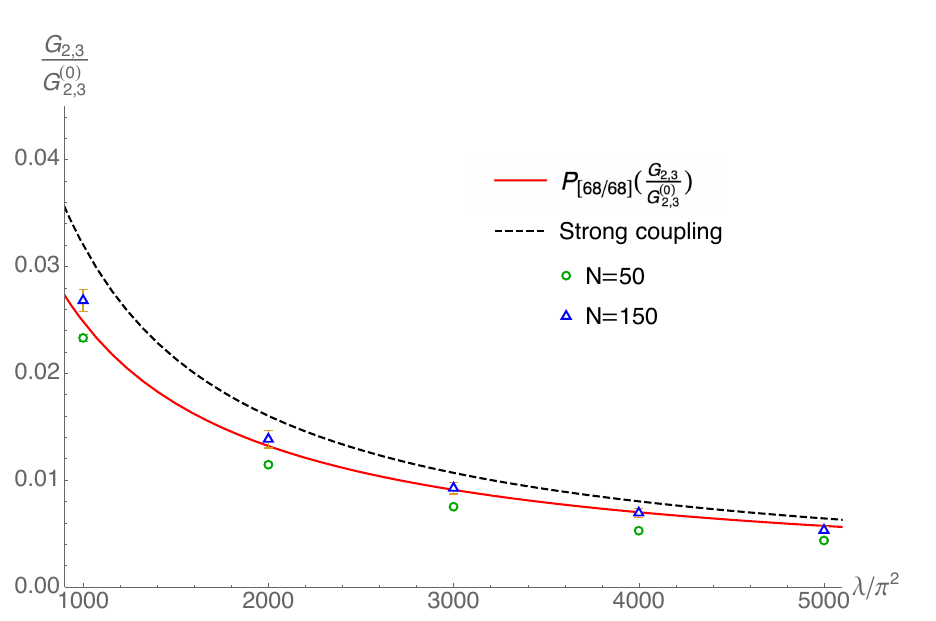
Figure 9 . Comparison between the Padé curve at M = 68 for the ratio G 2 , 3 /G (0) the large- λ theoretical prediction (4.19) (black dashed curve) and the points from the Monte Carlo simulations at N = 50 (green open circles) and at N = 150 (blue open